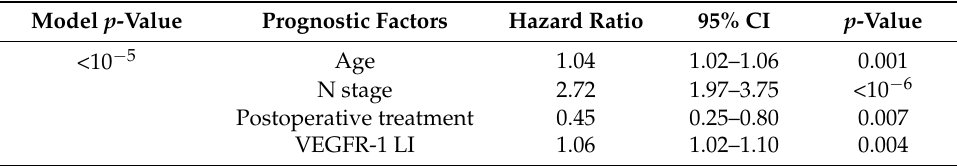
Table 2. Multivariate analysis of overall survival for VEGFR-1 LI ( n = 198). Model p -Value Prognostic Factors Hazard Ratio 95% CI p -Value <10 − 5 Age 1.04 1.02–1.06 0.001 N stage 2.72 1.97–3.75 <10 − 6 Postoperative treatment 0.45 0.25–0.80 0.007 VEGFR-1 LI 1.06 CI = confidence interval.